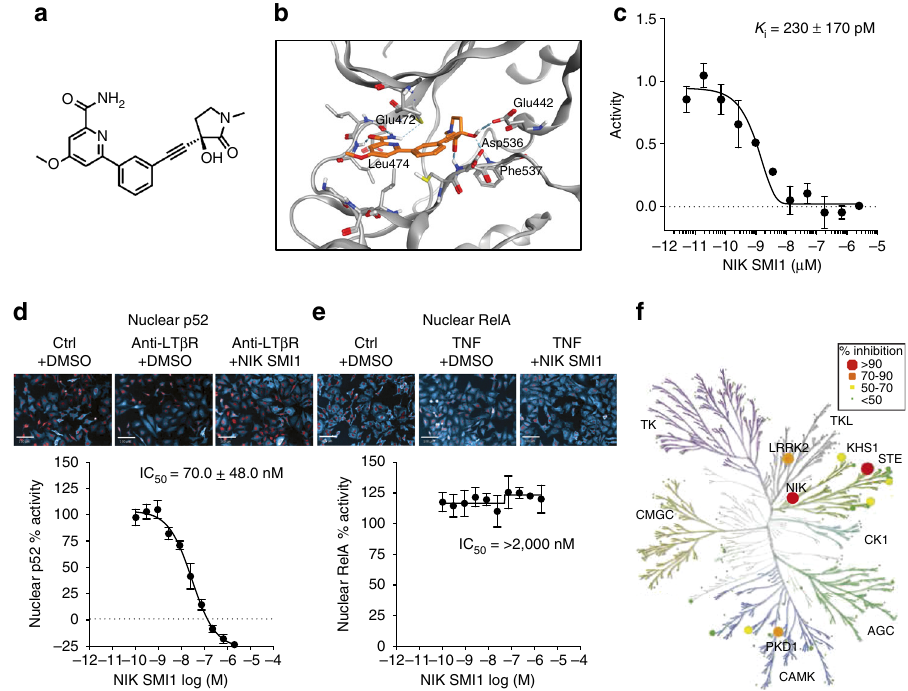
Fig. 1 NIK SMI1 is a highly selective and potent inhibitor of NIK. a Structure of NIK SMI1 b Model of NIK SMI1 (orange) docked into the 4G3E crystal structure. The interaction surface around the ligand is depicted in blue and hydrogen bond contacts are in green. c Inhibition of human NIK enzymatic activity by SMI1. A representative curve is shown, and the calculated K i represents the mean ± standard deviation of two independent experiments. d , e Inhibition of anti-LT β R induced non-canonical ( d ) and TNF induced canonical ( e ) signaling by NIK SMI1. We show representative images of p100/p52 ( d ) or RelA ( e ) in turquoise and nuclear staining for DRAQ5 in red (scale bar = 100 μ m), and calculated the titration curves. IC 50 measurements are listed as mean ± standard deviation from 5 – 8 independent experiments. f Kinase tree illustrating NIK SMI1 kinase selectivity when tested against a panel of 222 kinases. NIK and three potential off-target kinases, KHS1, LRRK2, and PKD1, are marked by colored circles representing percent inhibition observed at 1 μ